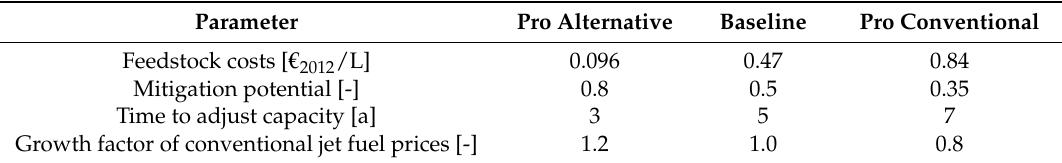
Table 3. Parameter values that define the three scenarios considered in the analysis of biofuels.